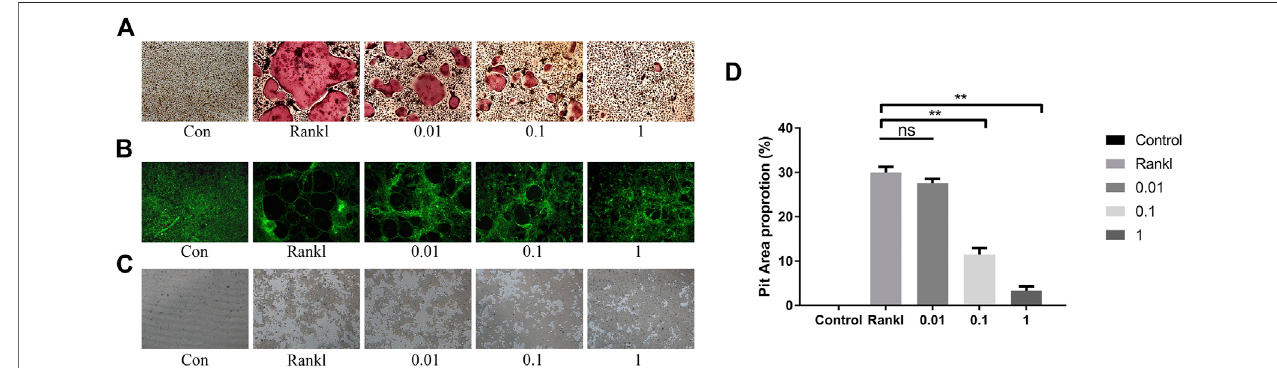
FIGURE 4 | BS restrained F-actin formation and bone resorption. (A) Representative images of TRAP-stained osteoclasts on the Osseo Assay plate. (B) F-actin ringassessedbyActin-Trackerstaining. (C) RepresentativeimagesofpitformationbyosteoclastsontheOsseoAssayplate. (D) Quanti fi cationofpitsformationarea.All bar graphs are presented as mean ± SD; n = 3. pp p < 0.01; ns, not statistically signi fi cant.